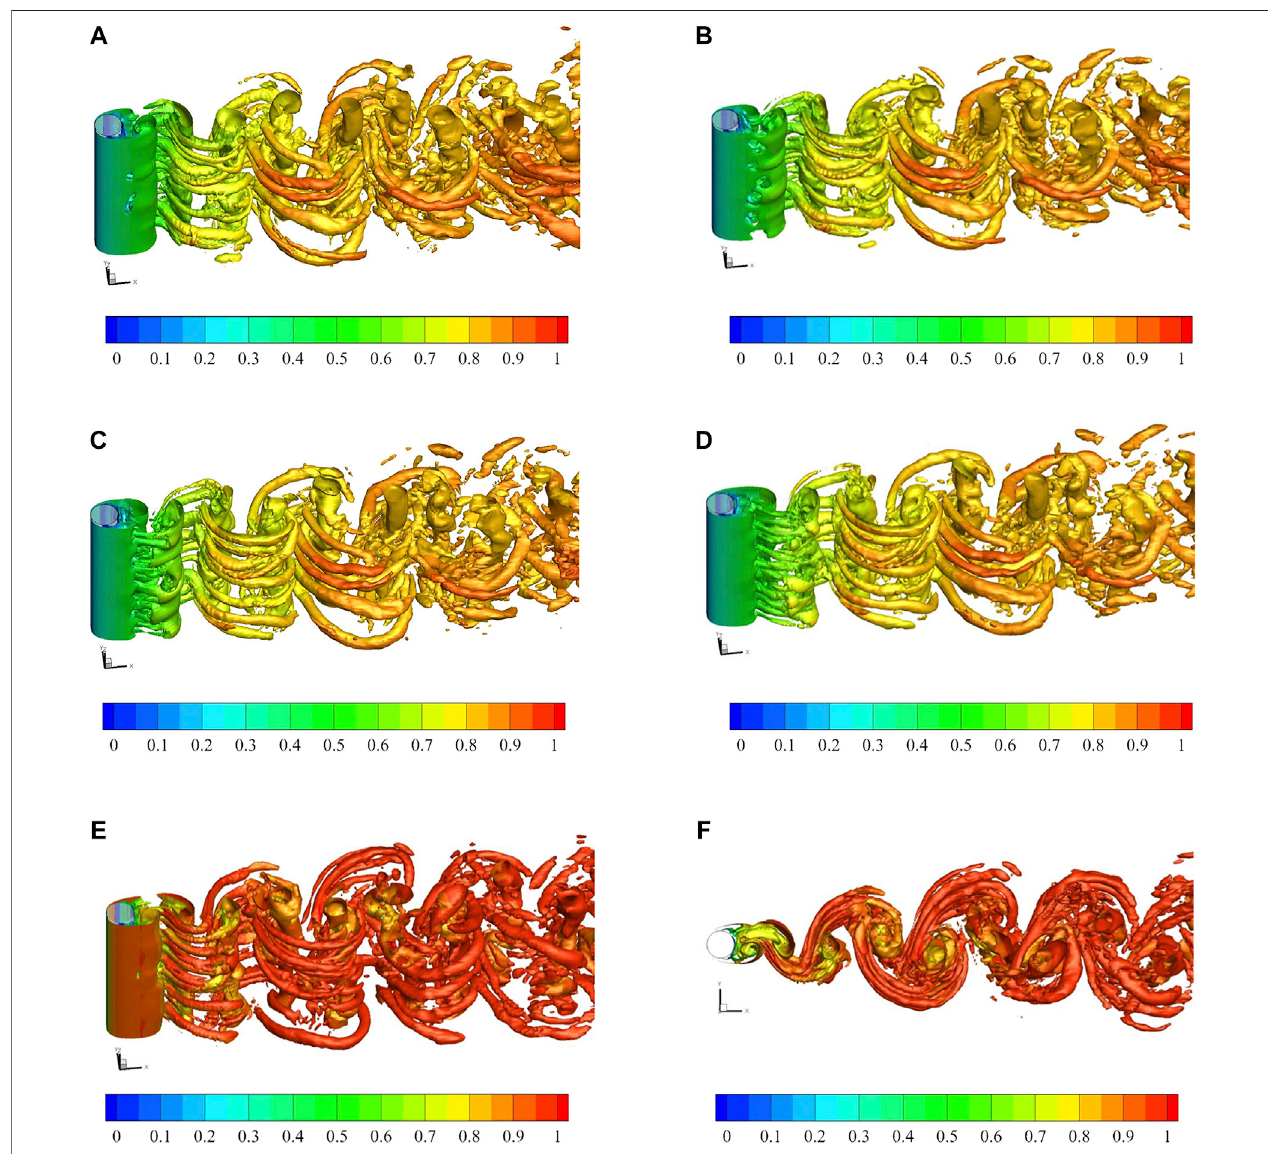
FIGURE3| Instantaneous vortexshownbyisosurfaces of Q = 0.2for fi veinstantsoftime.Note thatthese fi veinstantsstandfor fi vetypical moments inonevortex sheddingperiodsincethevortexsheddingperiod t vs is4.854(accordingtothevalueofStin Table2 ).In A – D ,theisosurfacesarecoloredbythetemperatureforthecase ofLBE(Pr = 0.025).In E and F ,theisosurfacesarecoloredbythetemperatureforthecaseofair(Pr = 0.71). (A) t = t 0 (atypicalmoment), (B) t = t 0 + 1, (C) t = t 0 + 2, (D) t = t 0 + 3, (E) t = t 0 + 4, and (F) t = t 0 + 4.